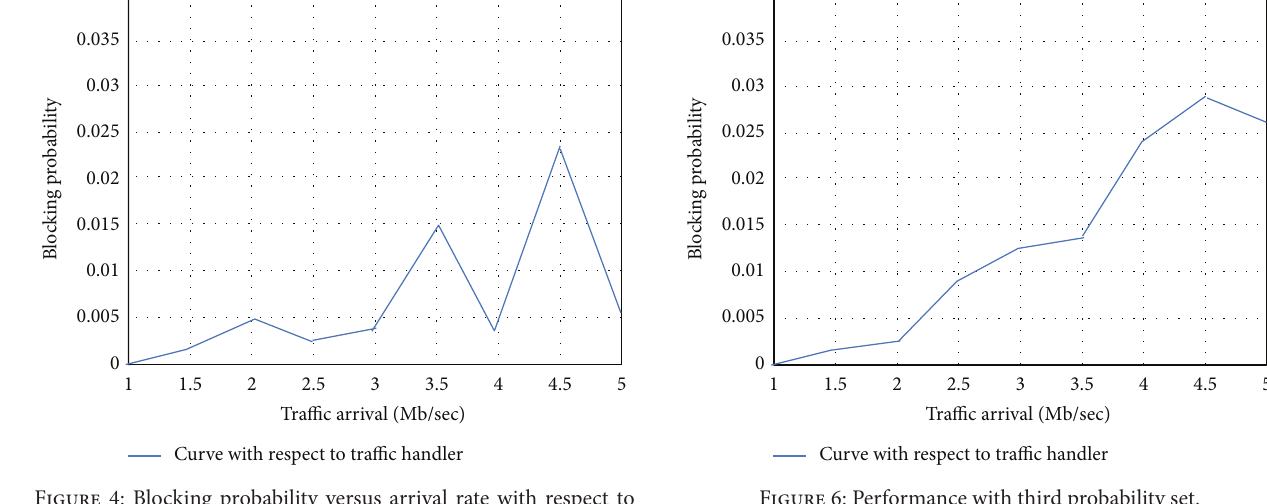
Figure 6: Performance with third probability set.